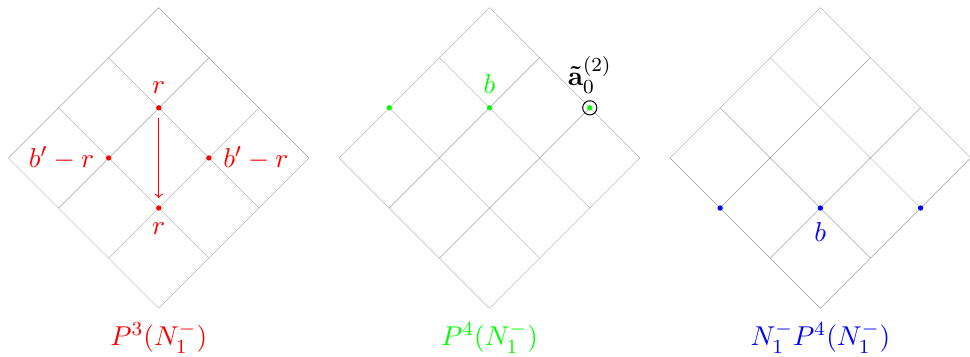
) of weight 3 with Hodge 1 ) of weight 4 1 . The colourings are in 2